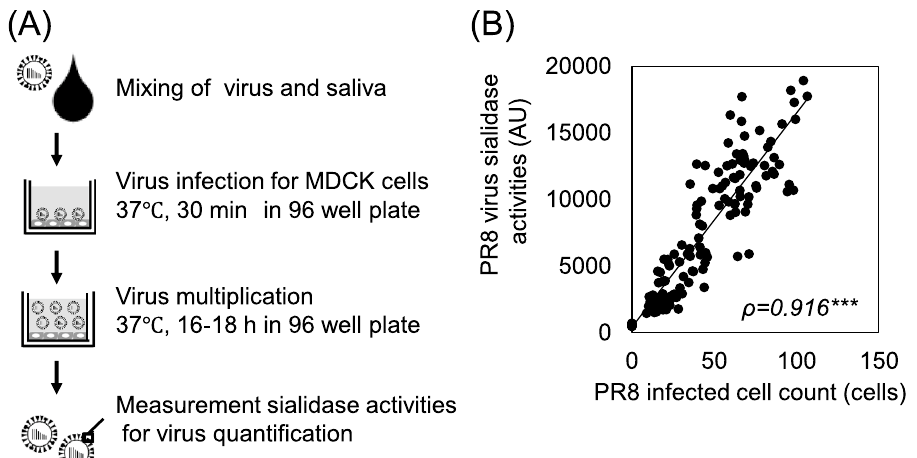
Figure 1. Construction of high-throughput assay of salivary anti-IAV activities. ( A ) Schematic of the measurement of salivary anti-IAV activities. ( B ) Correlation between viral sialidase activity and infected cell count. The plot indicates significant moderate positive correlation. ρ Spearman’s correlation coefficient. *** p <